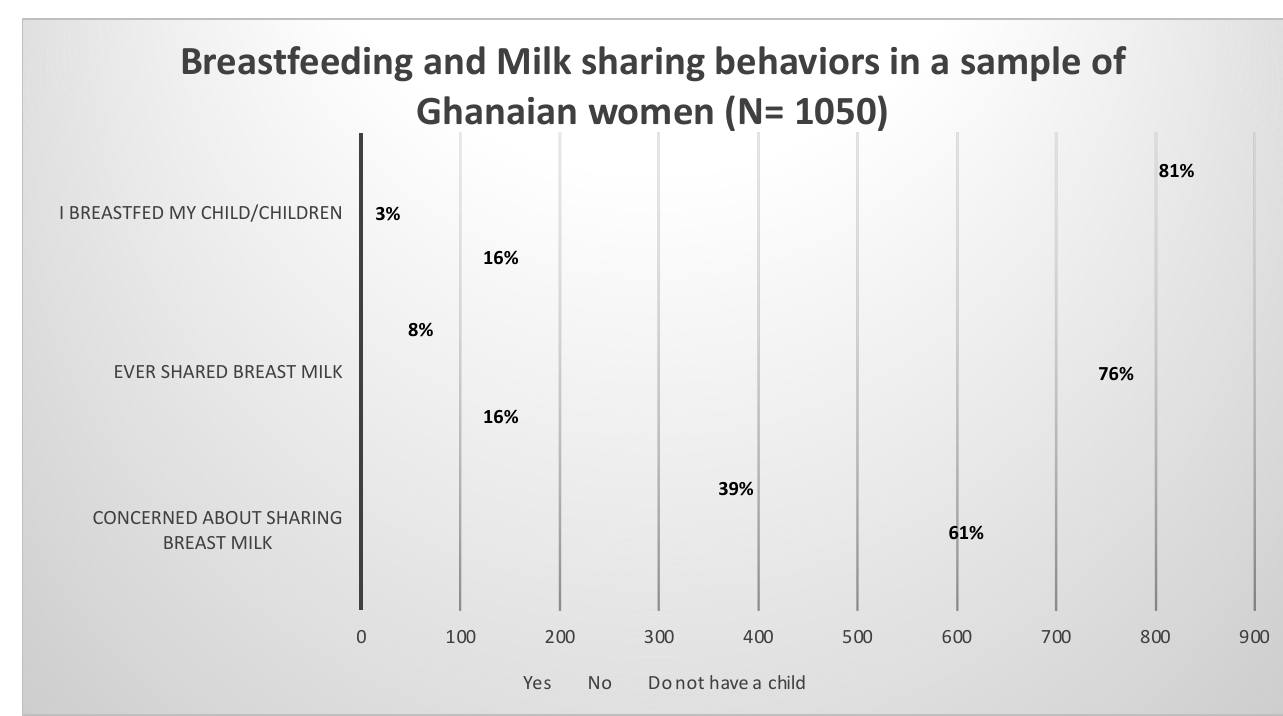
Figure 1. Breastfeeding and milk sharing behaviors in a sample of Ghanaian women.